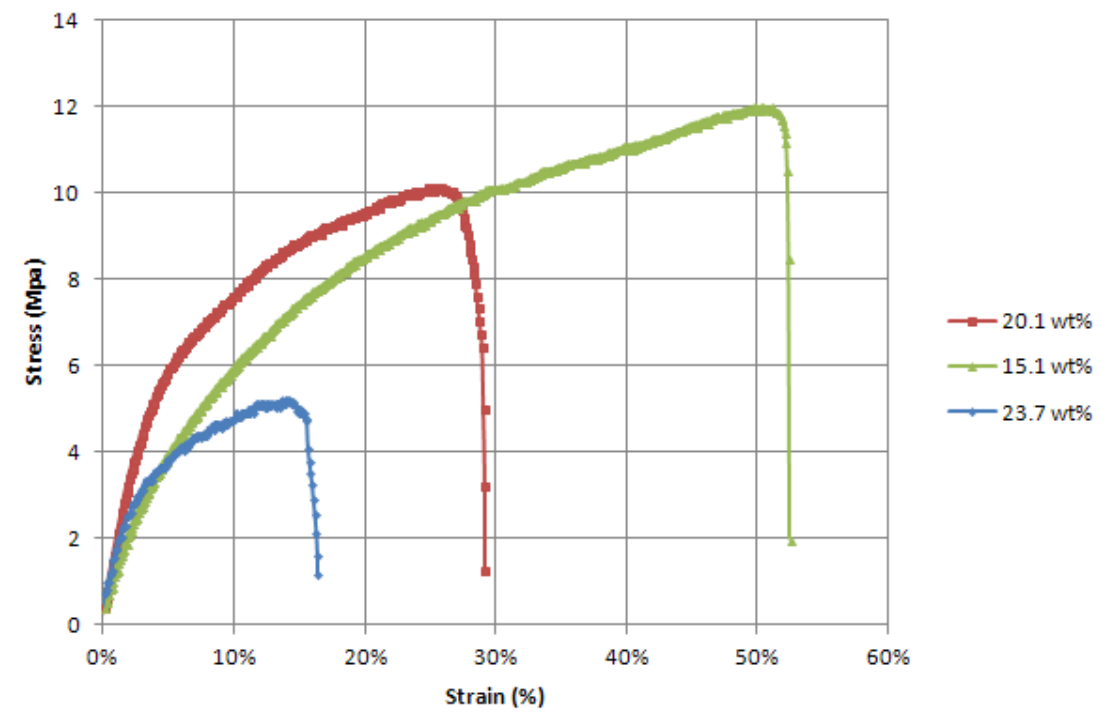
Figure 5. Load/strain curves of the dog bone shaped films of the pure coating at differents dry weight ratios of CPP105D to